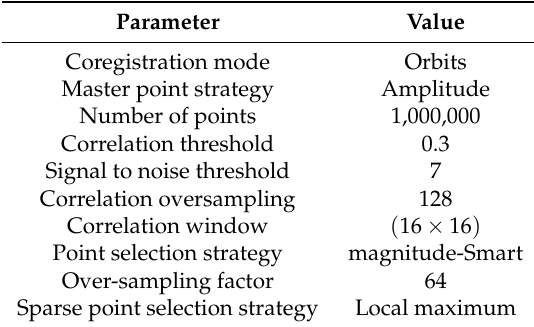
Table 1. Coregistrator parameters